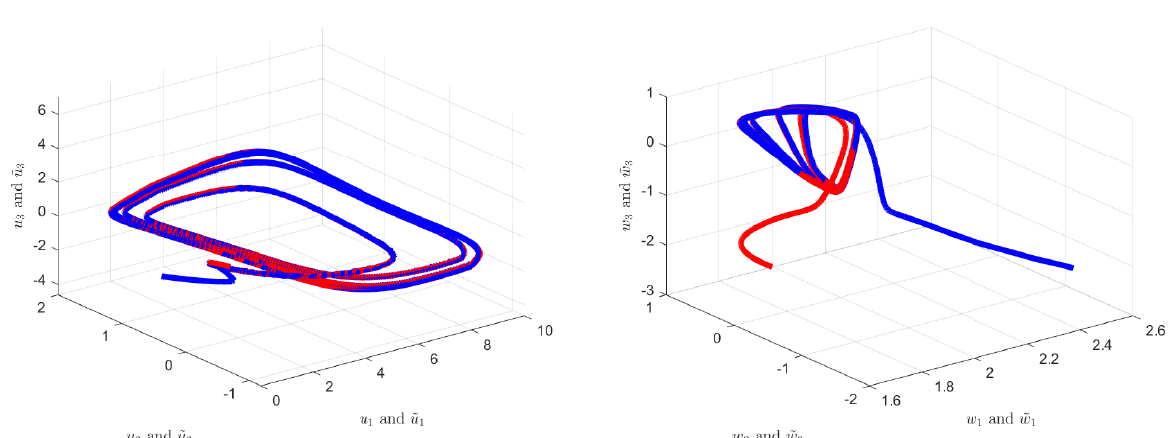
Figure 11. Chaotic behaviors e 1 ( t ) , e 2 ( t ) , e 3 ( t ) , and z 1 ( t ) , z 2 ( t ) , z 3 ( t ) of systems (72) and (73) with control inputs in Example